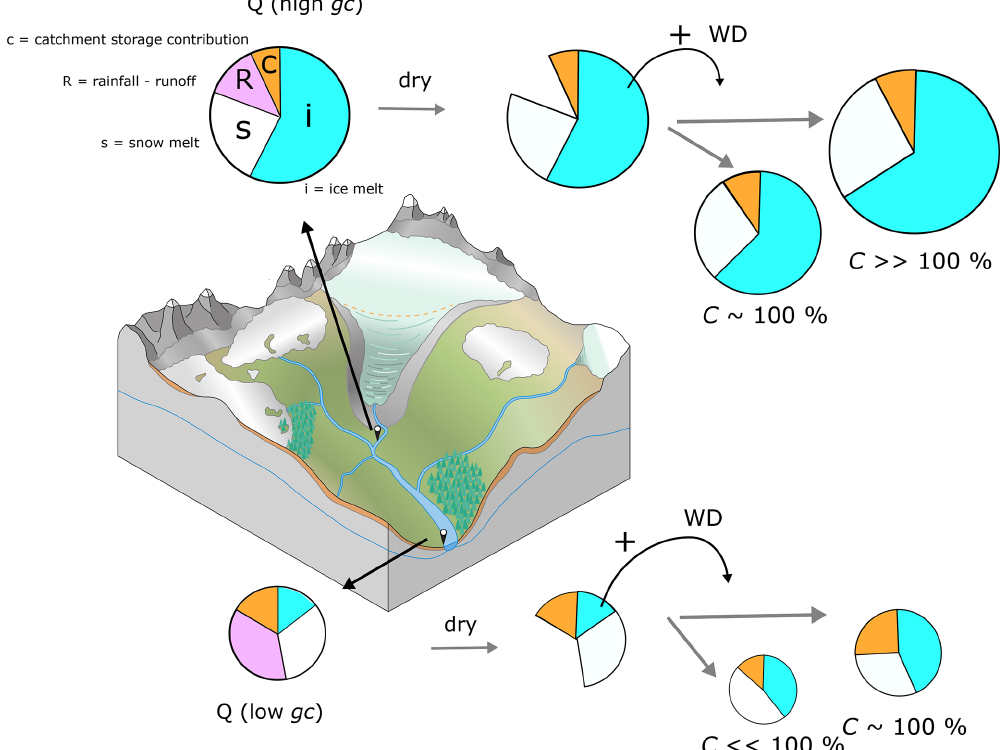
Figure 10. Conceptual overview of the different streamflow contributions in a glacierized catchment during summer and how they influence the response to warm and dry events (WD). The sketch in the middle shows a glacierized catchment, and the circles above and below represent the streamflow contributions for a for a catchment with a high (above) and low (below) relative glacier cover. Size of the circles scale with absolute specific streamflow amounts. The colors in the circles indicate the relative contributions of ice melt, snowmelt, rain, and other catchment storages. During a dry event, the rainfall runoff contribution is lacking, and depending on the relative contribution of the other streamflow components (snowmelt, glacier melt, and catchment storage) and their anomalies, glacier melt can compensate ( C = 100%) or overcompensate ( C >